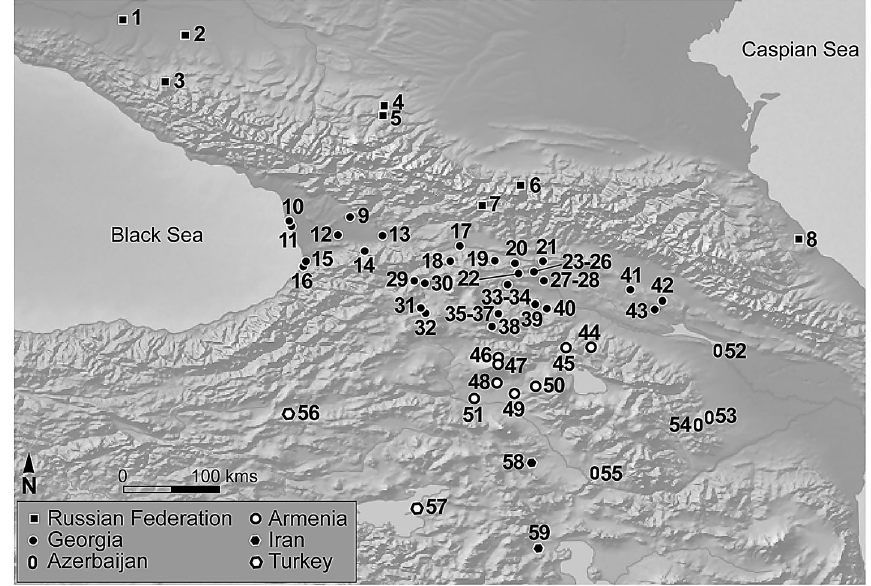
6. Koban; 7. Chidgom; 8. Velikent I; 9. Etseri village; 10. Dikha-Gudzuba; 11. Pichori; 12. Nosiri; Megrelia; 13. Gabashvilis Gora; 14. Vani; 15. Choloki; 16. Namcheduri; 17. Tsagvli; 18. Natsargora; 19.